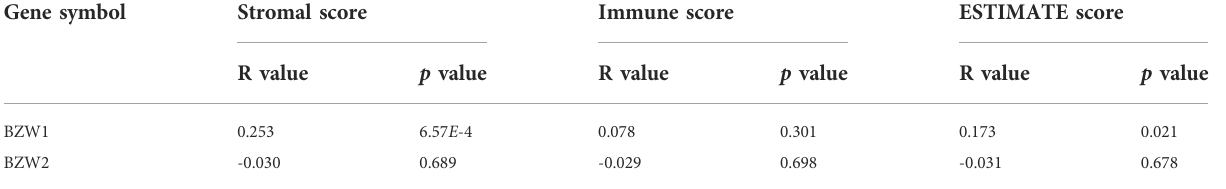
TABLE 1 Correlation of BZW1/2 expression and ESTIMATE-Stromal-Immune score